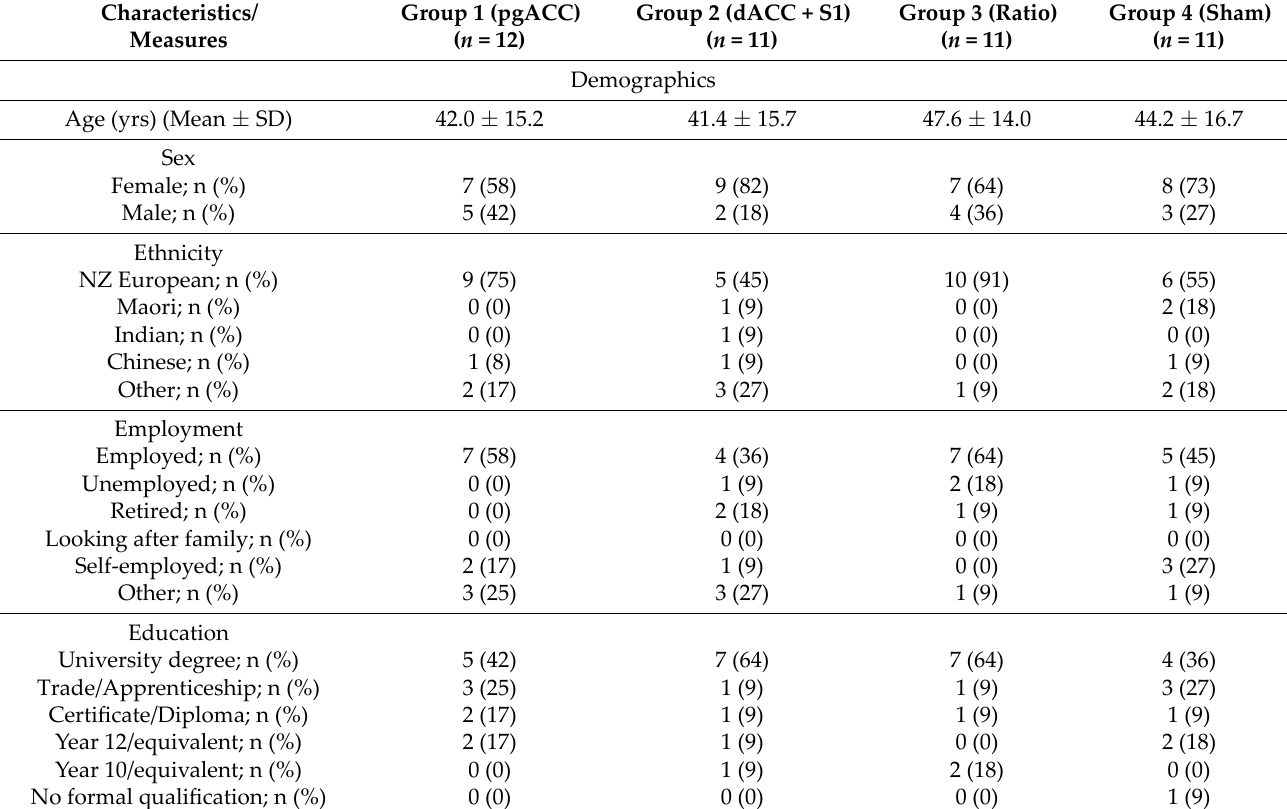
Table 1. Demographics and clinical characteristics of